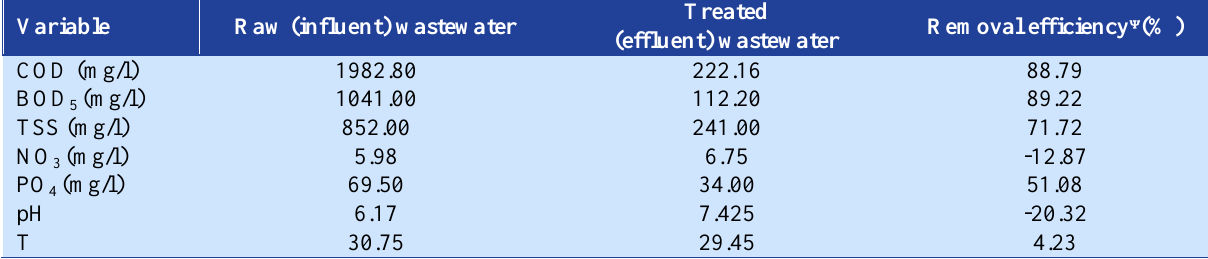
Table 4. Removal efficiency of important variables in Pelareh Dairy Industry wastewater treatment plant Variable Raw (influent) wastewater